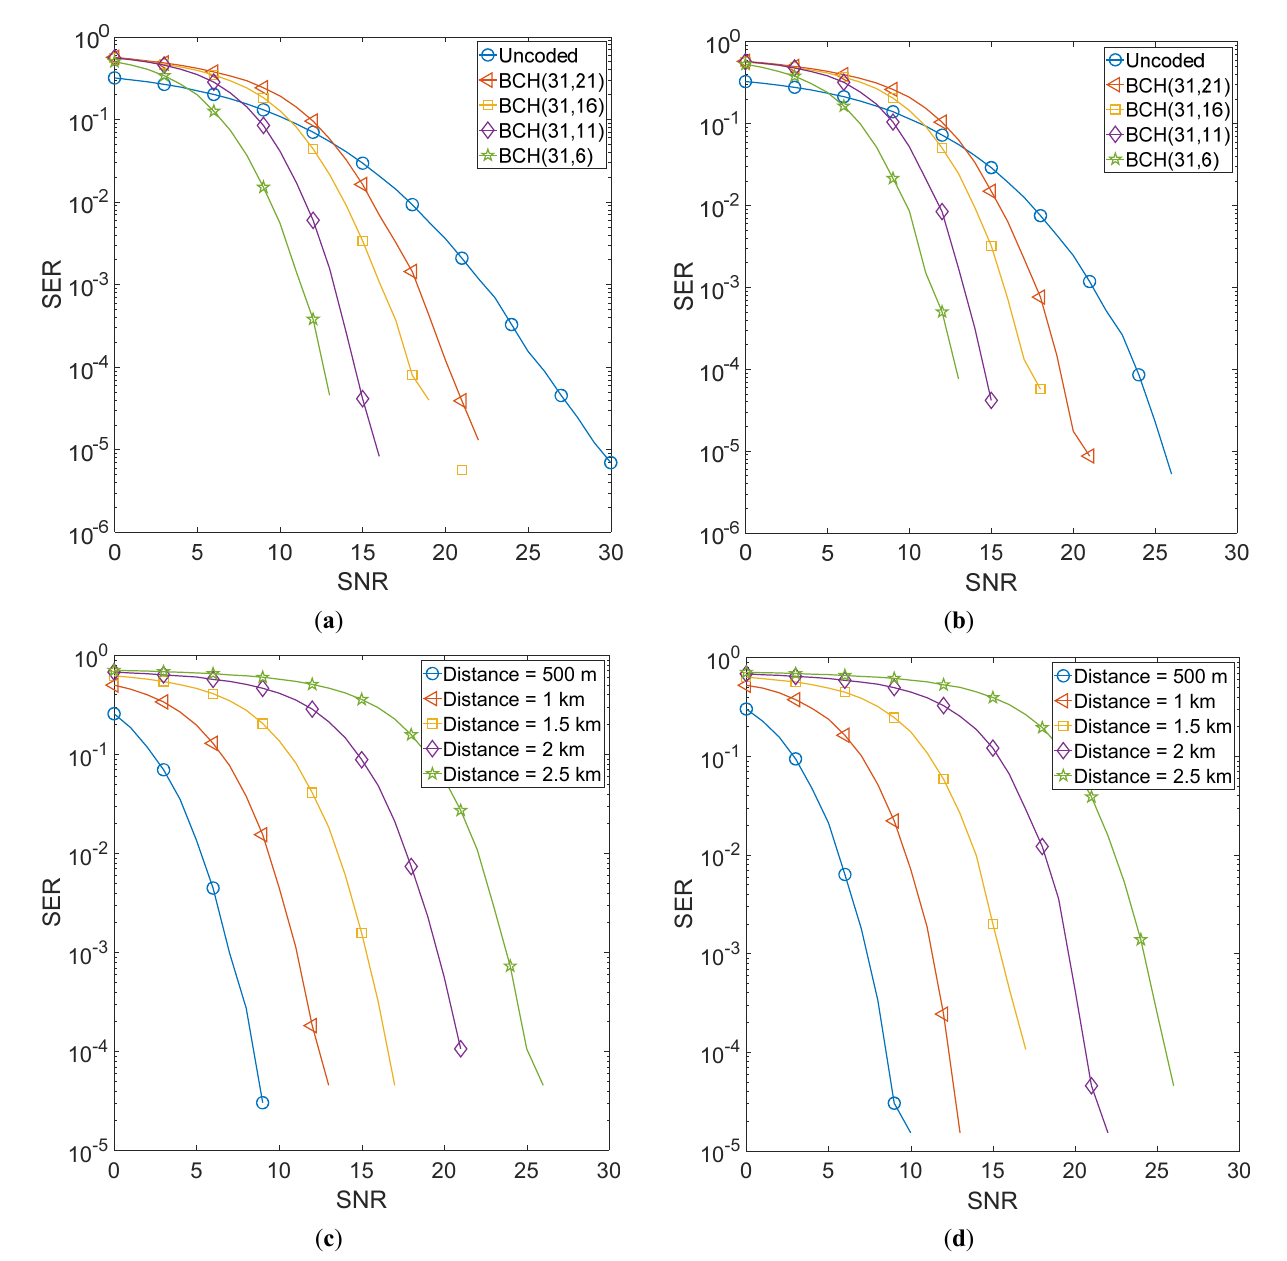
Figure 3. BCH encoded 4QAM-GFDM schemes. ( a ) Comparison of selected BCH schemes with MF equalizer. ( b ) Comparison of selected BCH schemes with ZF equalizer. ( c ) Error performance as a function of Tx-Rx distance for BCH(31,6) scheme with MF equalizer. ( d ) Error performance as a function of Tx-Rx distance for BCH(31,6) scheme with ZF equalizer.